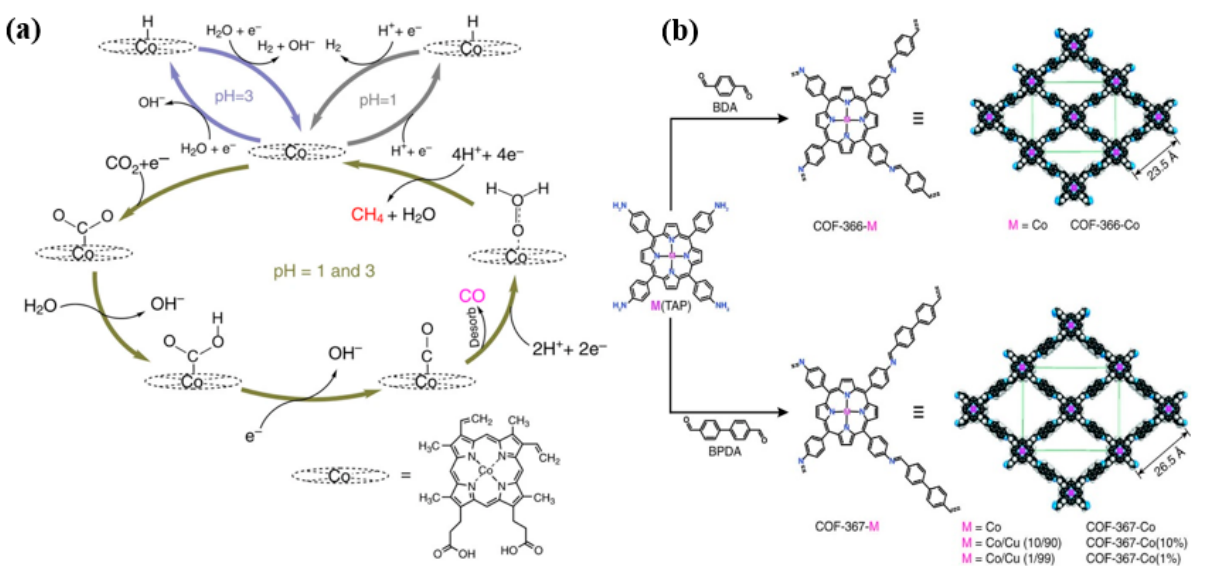
Figure 11. ( a ) Proposed mechanistic scheme for the electrochemical reduction of CO 2 on Co protoporphyrin. (Reprinted with permission from ref. [126]. 2015, American Association for the Advancement of Science). ( b ) Design and synthesis of metalloporphyrin-derived 2D covalent organic frameworks. Materials Studio 7.0 was used to generate space-filling structural models of COF-366-M and COF-367-M, which were then improved with experimental PXRD data. (Reprinted with permission from Ref. [126]. Copyright 2015 American Association for the Advancement of Science).